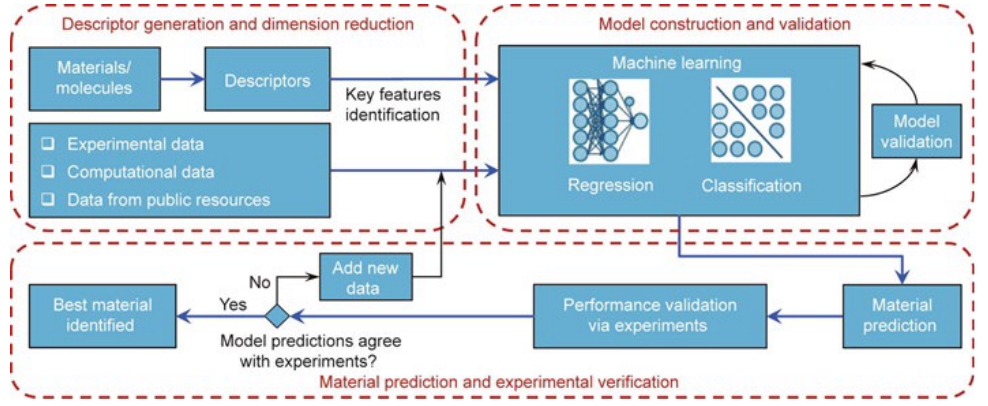
Figure 1. Illustration of ML workflow [16]. Copyright 2019 Elsevier.